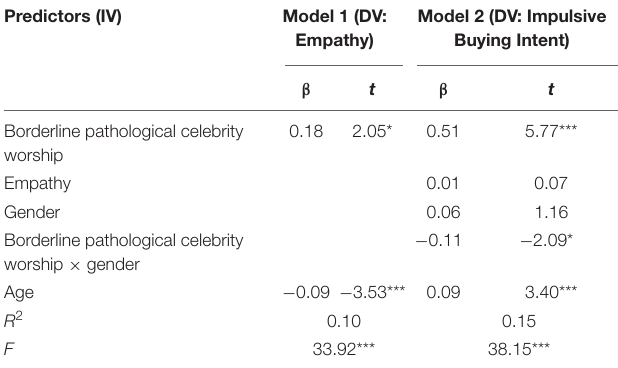
Frontiers in Psychology |